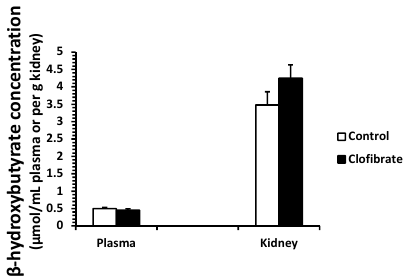
Figure 1. β -Hydroxybutyrate concentration in plasma and kidneys of neonatal piglets. Values are means ± SE ( n = 5).